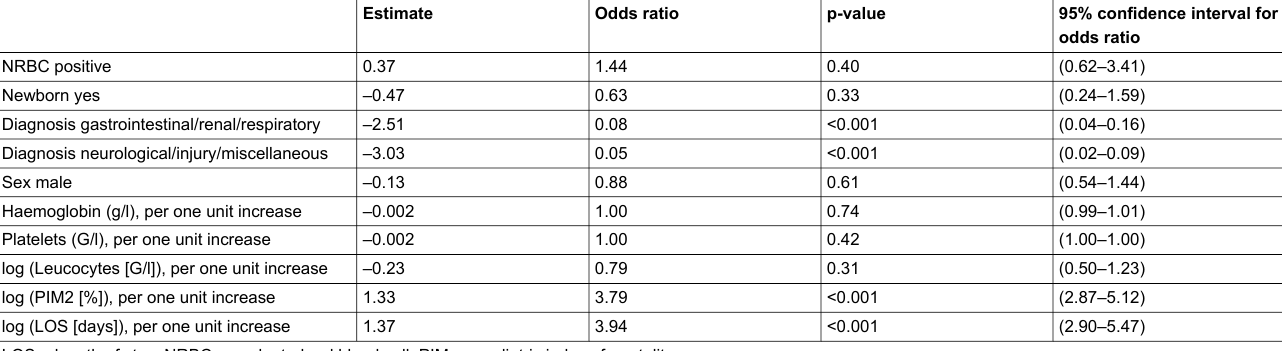
Table 3: Multiple logistic regression for the composite endpoint (dependent variable). The composite endpoint (death and/or ventilation and/or renal replacement therapy and/or inotropic support) had a value yes if at least one of the four outcome variables mortality, ventilation, renal replacement therapy or inotropic support was assigned with a yes. Interpretation for “newborn yes” (binary variable): the odds for a “yes" for the composite endpoint are decreased by a factor of exp(–0.47) = 0.627 for patients with a newborn status of “yes" compared to those with a “no" for newborn. Interpretation for “haemoglobin (g/l)” (continuous variable): the odds for having a “yes" for the composite endpoint are decreased by a factor of exp(–0.002) = 0.998 for an increase of haemoglobin by one unit. This effect is multiplicative, i.e., for a value of haemoglobin that is by a factor of 2 higher, the odds for a “yes" are decreased by a factor of exp(2*-0.002) = 0.997. Interpretation for “log(PIM2)”: an increase of log(PIM2) by 1% increases the odds for having a “yes" for the composite endpoint by a factor of exp(1.333) = 3.794.